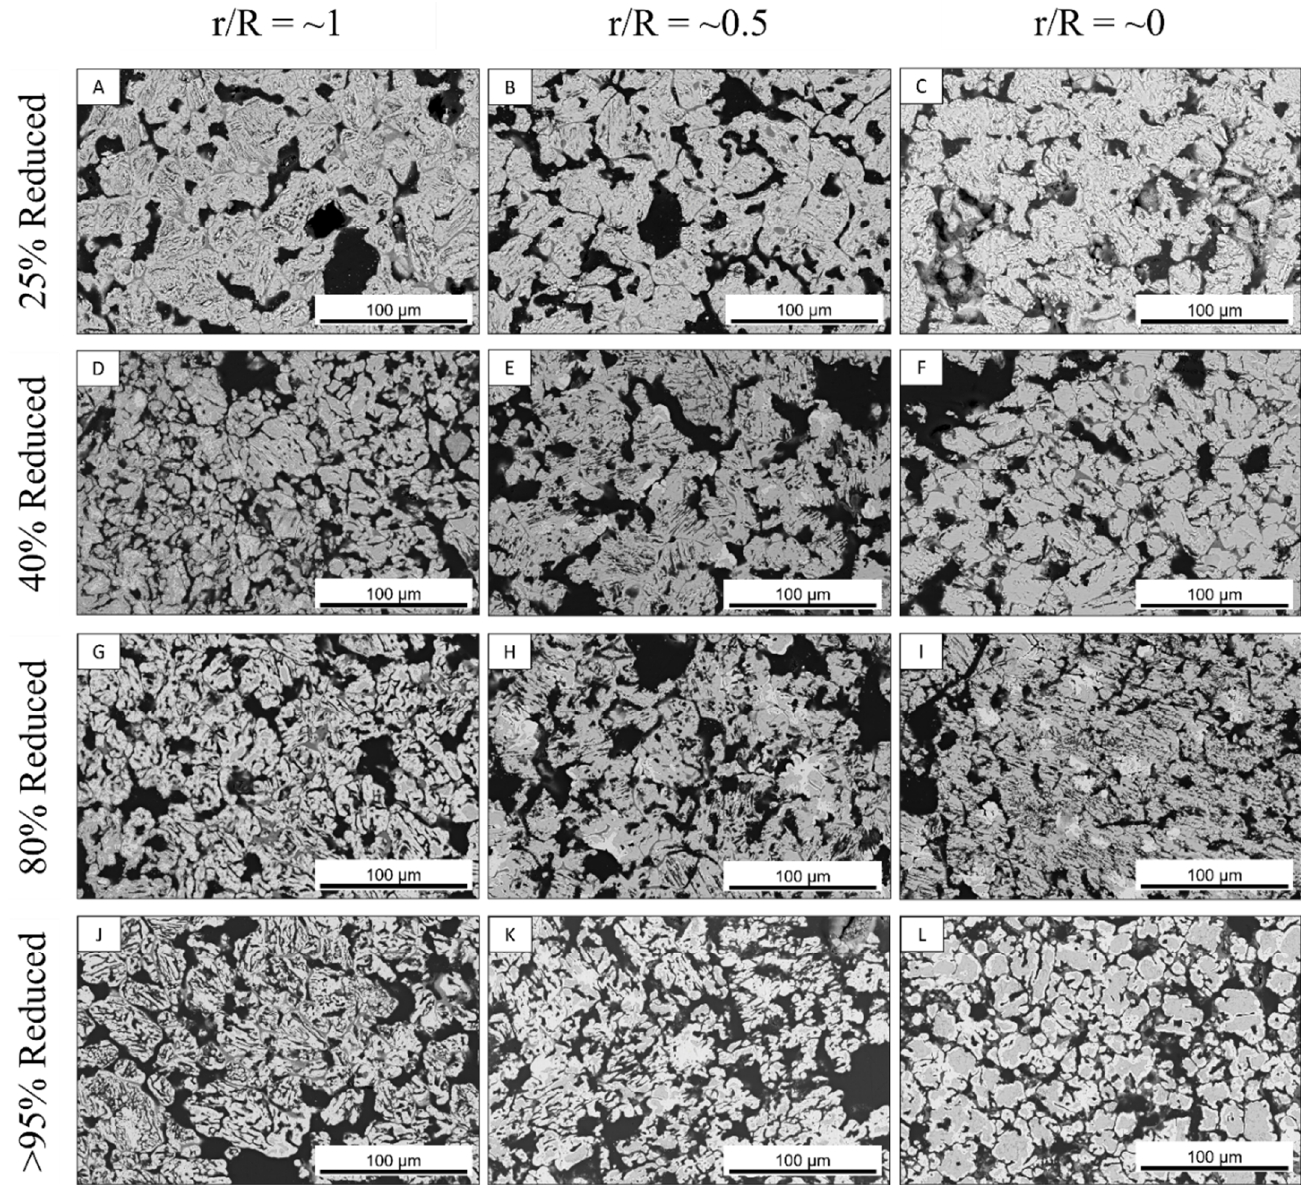
Figure 5. SEM Images of partially reduced pellet using H 2 /CO = 75/18 gas mixture. SEM Images of 25% reduced pellet taken in ( A ) shell region, ( B ) middle region and ( C ) core region, 40% reduced pellet taken in ( D ) shell region, ( E ) middle region and ( F ) core region, 80% reduced pellet taken in ( G ) shell region, ( H ) middle region and ( I ) core region, >95% reduced pellet taken in ( J ) shell region, ( K ) middle region and ( L ) core region.